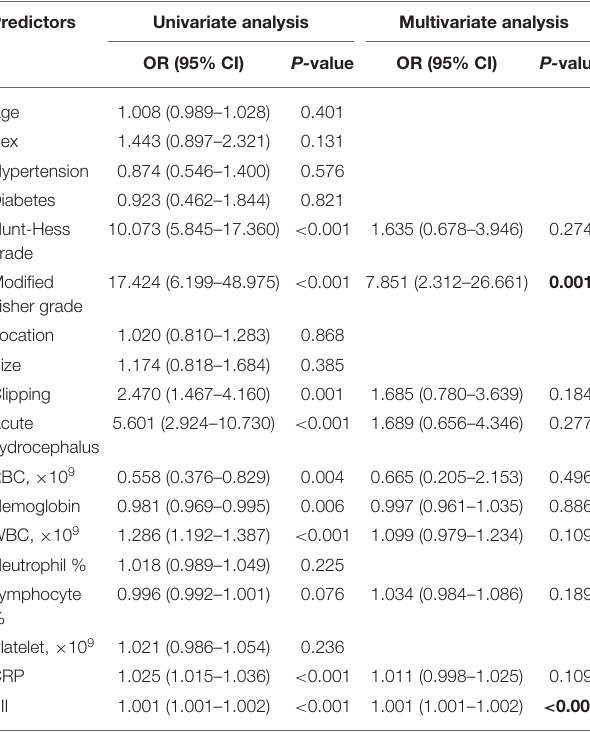
TABLE 1 | Comparison of demographic, clinical, and laboratory data in patients with aneurysmal SAH according to the development of delayed cerebral ischemia. Variable